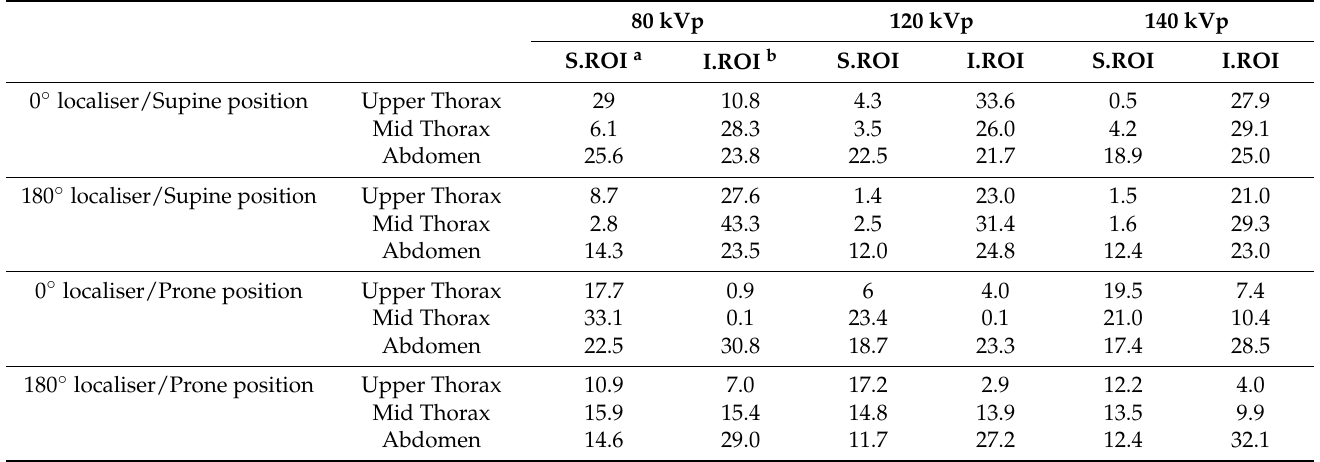
Table 1. The absolute computed tomography (CT) number difference of the ROI between the 100 mm off-centring points above and below the gantry iso-centre for 0° and 180° localisers and supine and prone phantom positions.